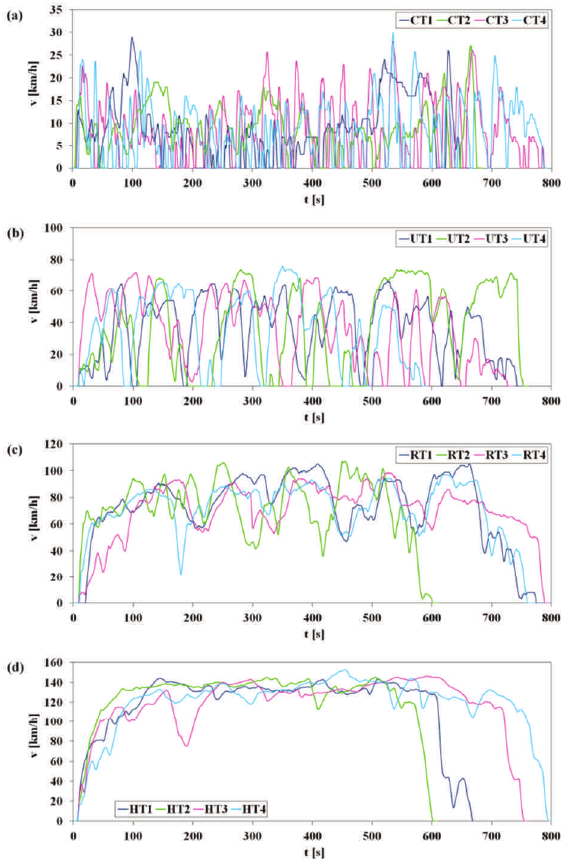
Fig. 2. Realizations of the vehicle velocity vs. time process for: a) urban traffic congestions (CT); b) urban traffic (UT); c) extra-urban traffic (RT); d) high-speed traffic